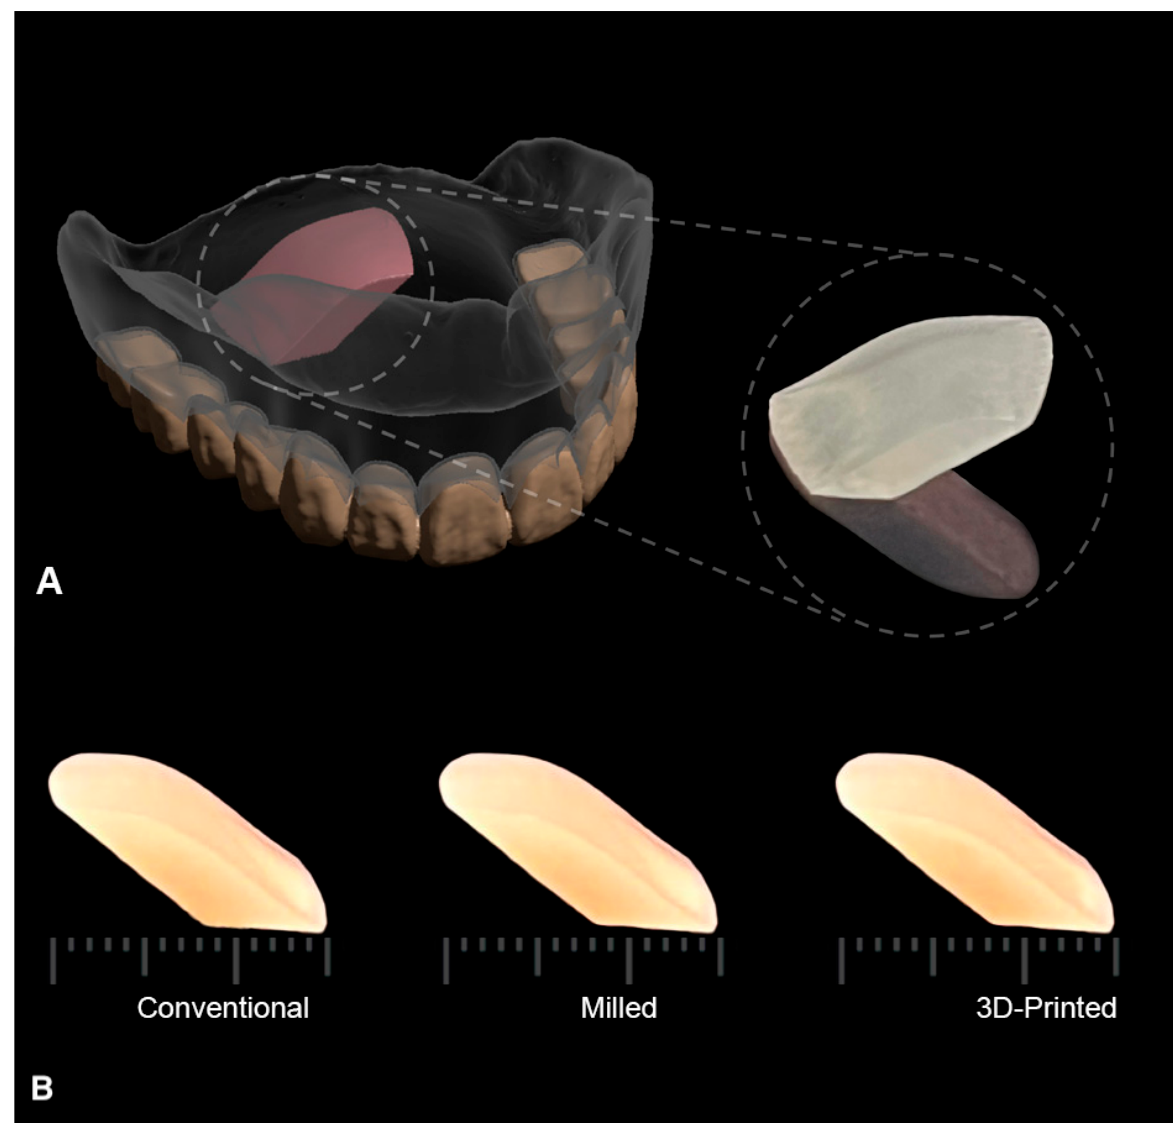
Figure 1. ( A ) Illustration of the designed test specimen as a section of the maxillary complete denture marked in pink. Enlarged specimen is shown on the right side. ( B ) Scale bar showing the standardized dimensions of the fabricated specimens in each test group: conventional, milled, and 3D-printed, to control all variables except for the material of fabrication.